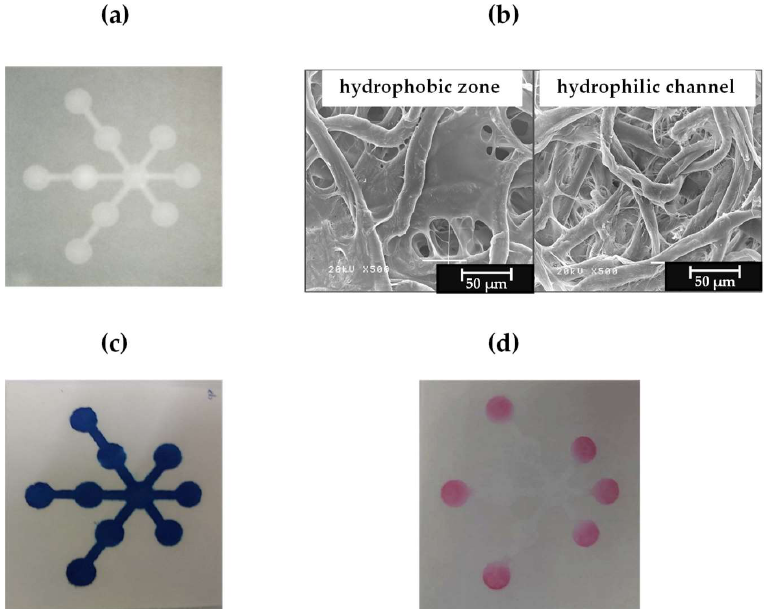
Figure 3. ( a ) The fabricated μPAD, ( b ) the SEM images of the μPAD at the hydrophobic and hydrophilic areas, ( c ) the blue dye solution wicking through the hydrophilic region of the μPAD, and ( d ) the μPAD after reaction with nitrite and nitrate.